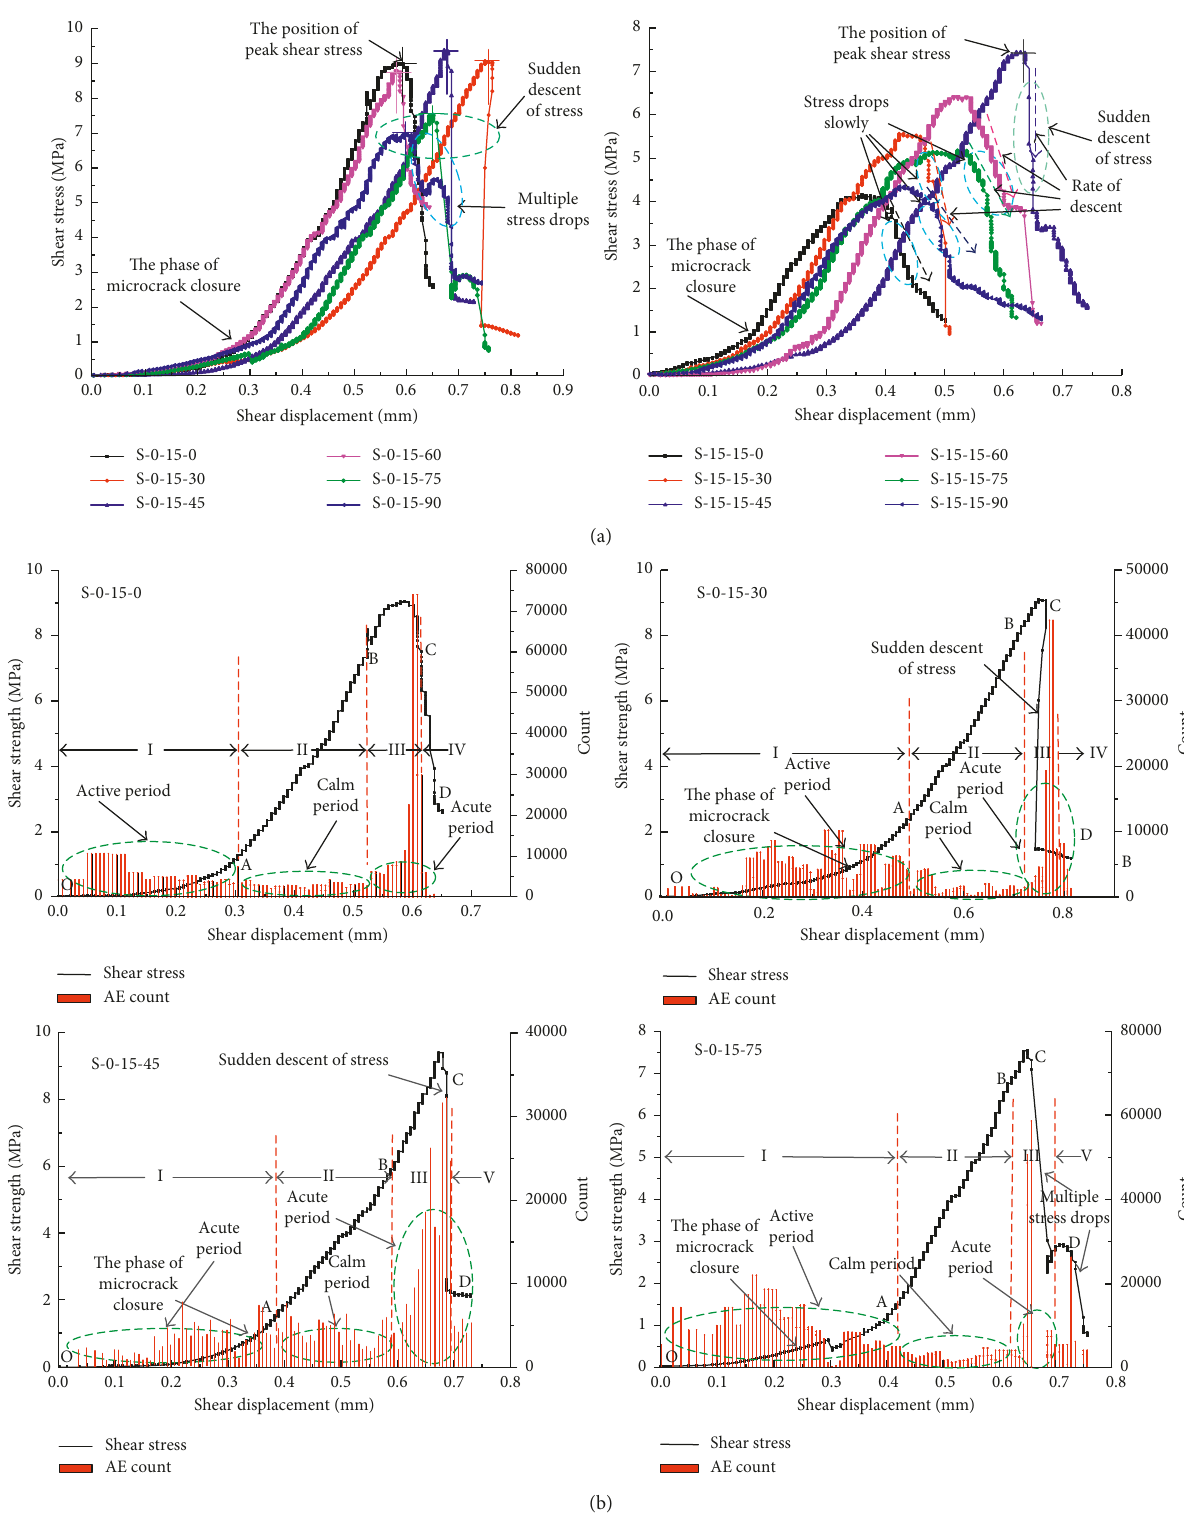
Figure 9: The effect of joint inclination on the shear stress-displacement curve and AE count: (a) the shear stress-shear displacement curves of different joint inclinations; (b) the variation of acoustic emission count for different angle